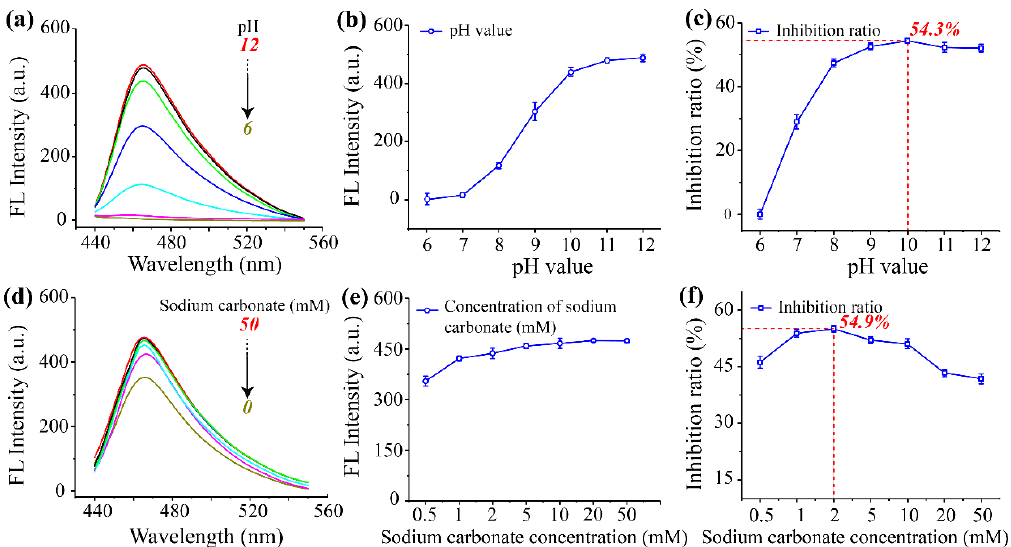
Figure 2. The optimization of pH values and sodium carbonate concentrations. ( a ) fluorescence spectra, ( b ) fluorescence intensity and ( c ) inhibition ratio at different pH values, ( d ) fluorescence spectra, ( e ) fluorescence intensity and ( f ) inhibition ratio at different sodium carbonate concentrations.